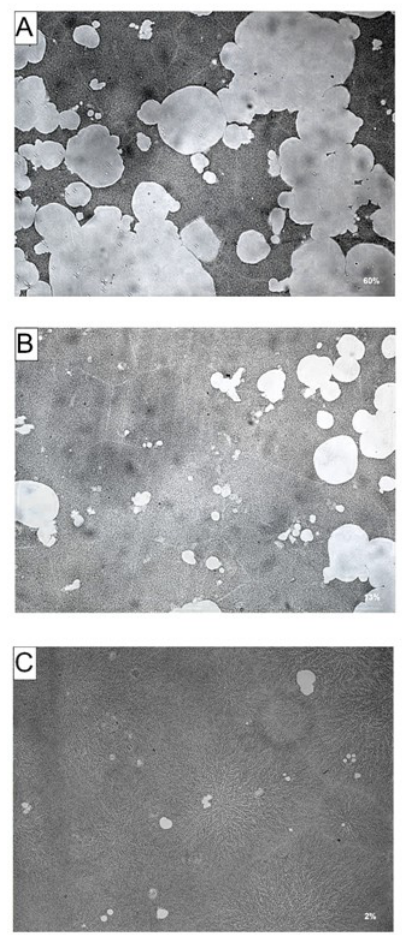
Figure 4. Effects of AA and DHA on resorption pit formation in Corning Osteo